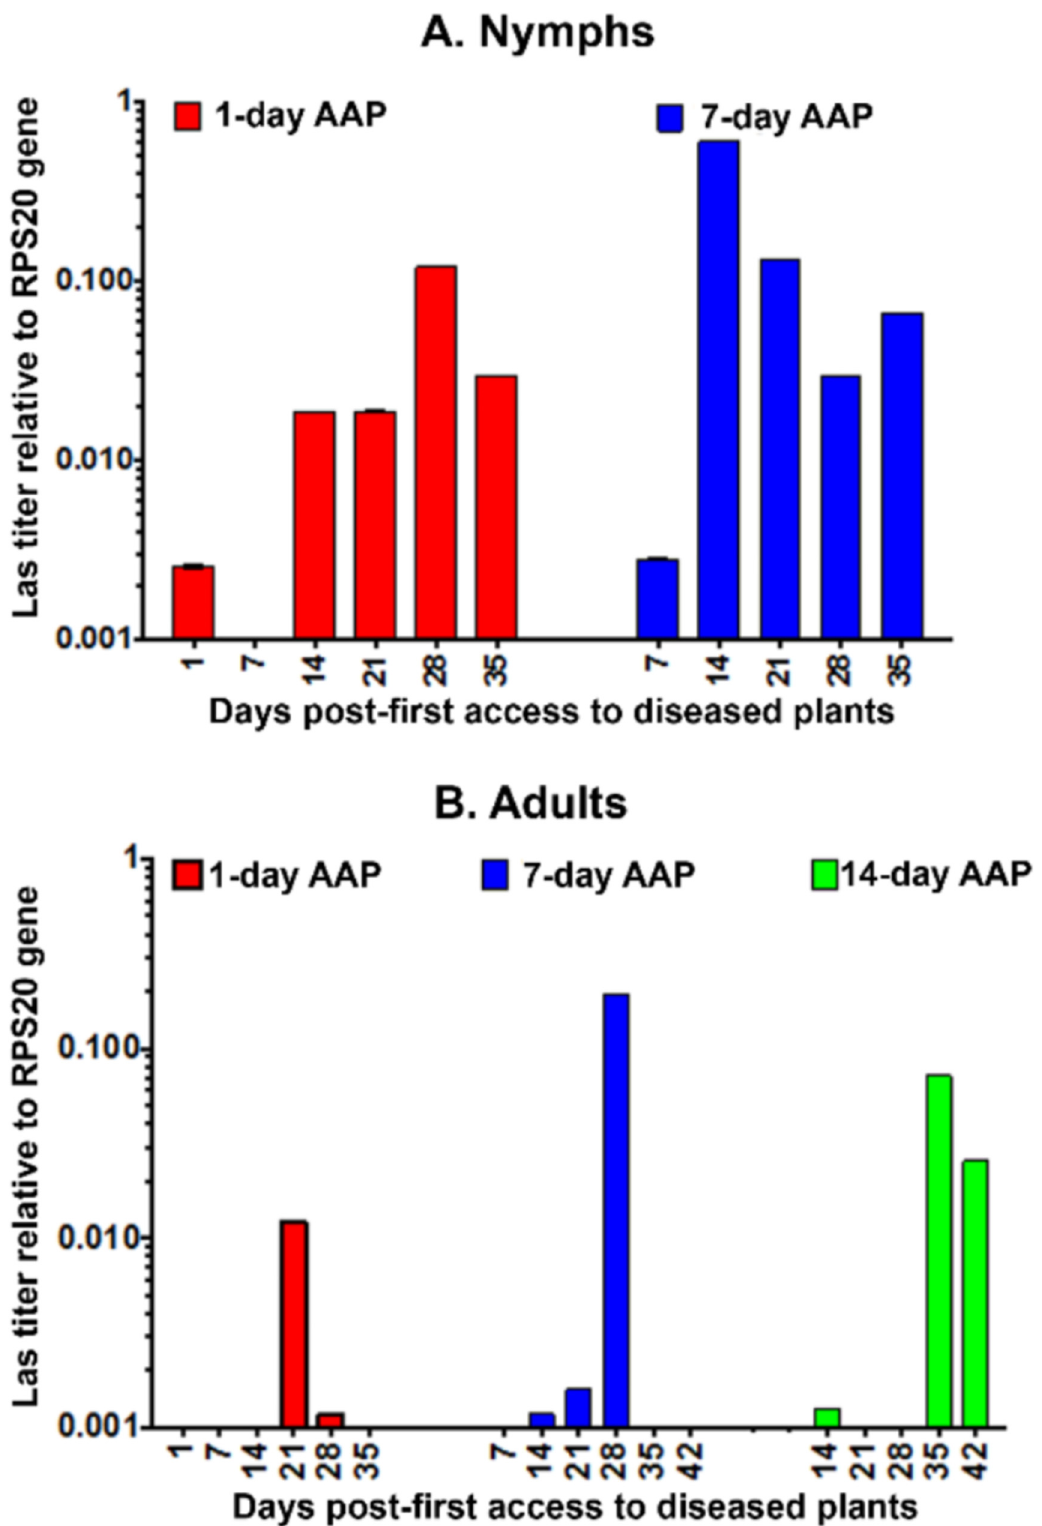
Fig 1. Las titer (Log scale) in D . citri , relative to that of the RPS20 psyllid gene, at various times following the start of 1, 7 or 14-day acquisition access periods (AAP) on Las-infected citrus plants as nymphs (A) or adults (B).